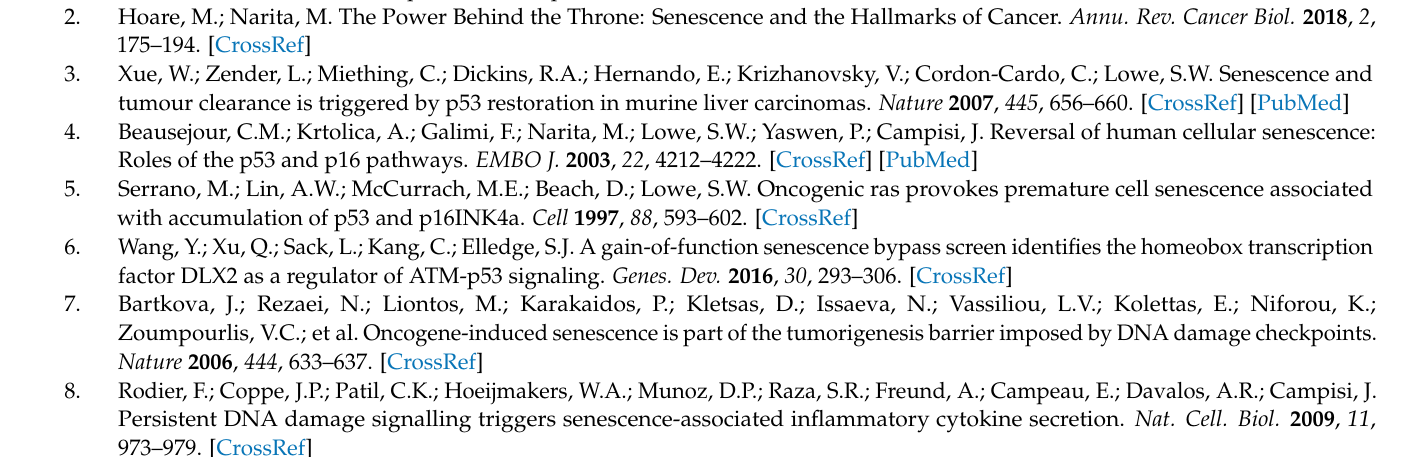
Table S2: Ingenuity Pathway Analysis results; Video S1: atm − / − adult fishes have no defect in their motility or morphology; Figure S1: Survival with different concentrations of Etoposide and H 2 O 2 ; Figure S2: tp53 target genes are not induced in 5 dpf larvae treated with H 2 O 2 . Figure S3: Comparison between Cy3 and EGFP method shows no significant differences between left lobe liver size measured by Cy3 or EGFP fluorescence. Figure S4: Phenotype of WT and hUHRF1 larvae after NAC